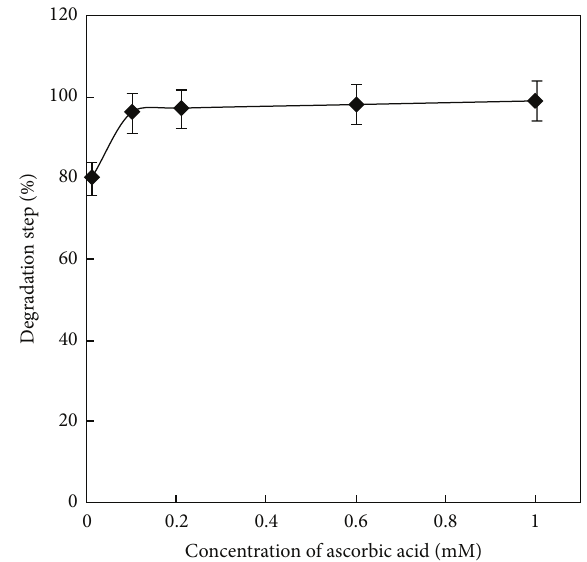
Figure 5: Effect of the concentration of ascorbic acid on the step of degradation, 𝑆 𝐷 , of p